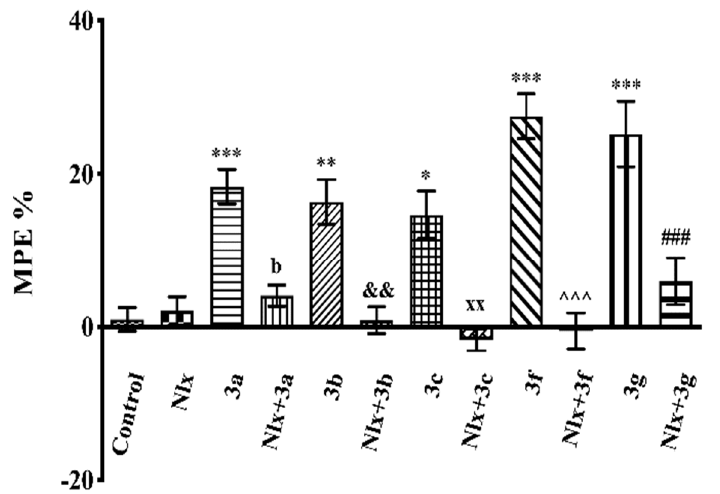
Figure 8. Effect of naloxone (5.48 mg/kg, i.p.) pre-treatment on antinociceptive activity induced by compounds 3a – 3c , 3f , and 3g in the hot-plate test. Significance against control group * p < 0.05, ** p < 0.01, *** p < 0.001; significance against compound groups: 3a b p < 0.01; 3b && p < 0.01; 3c xx p <